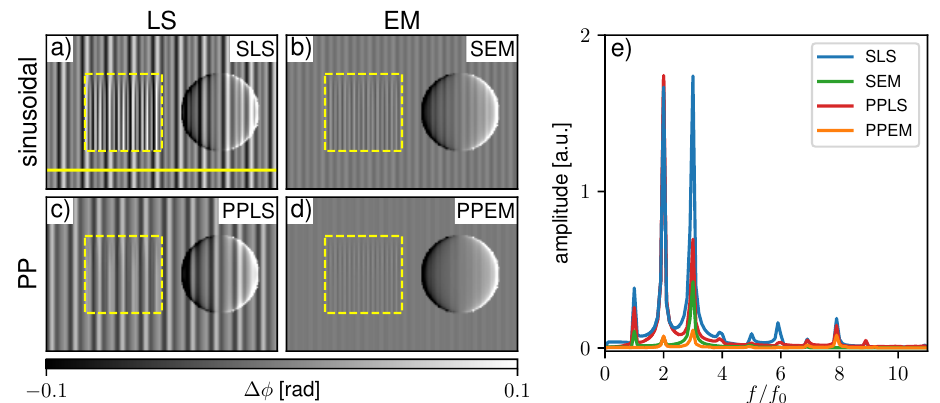
Figure 5. Processed differential-phase contrast images for ( a ) sinusoidal least square (SLS), ( b ) sinusoidal expectation maximization (SEM), ( c ) periodic polynomial least square (PPLS), and ( d ) periodic polynomial expectation maximization (PPEM) of the simulated two-grating interferometer with phase-stepping jitter. The yellow dashed squares mark the region with a scatter wedge with increasing scattering strength from top to bottom. ( e ) Corresponding Fourier spectra generated along the yellow line in ( a ).